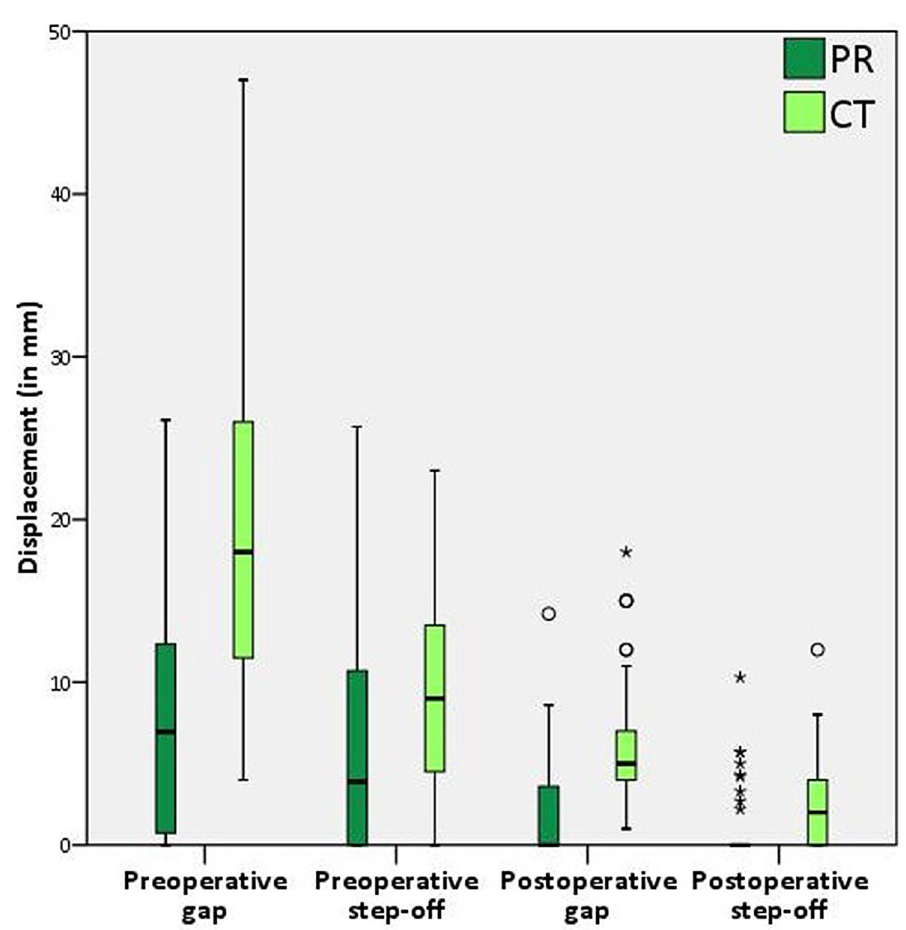
Figure 1. A boxplot comparing the pre- and postoperative gap and step-off measurements on radiographs (PR, in dark green) and CT scans (in light